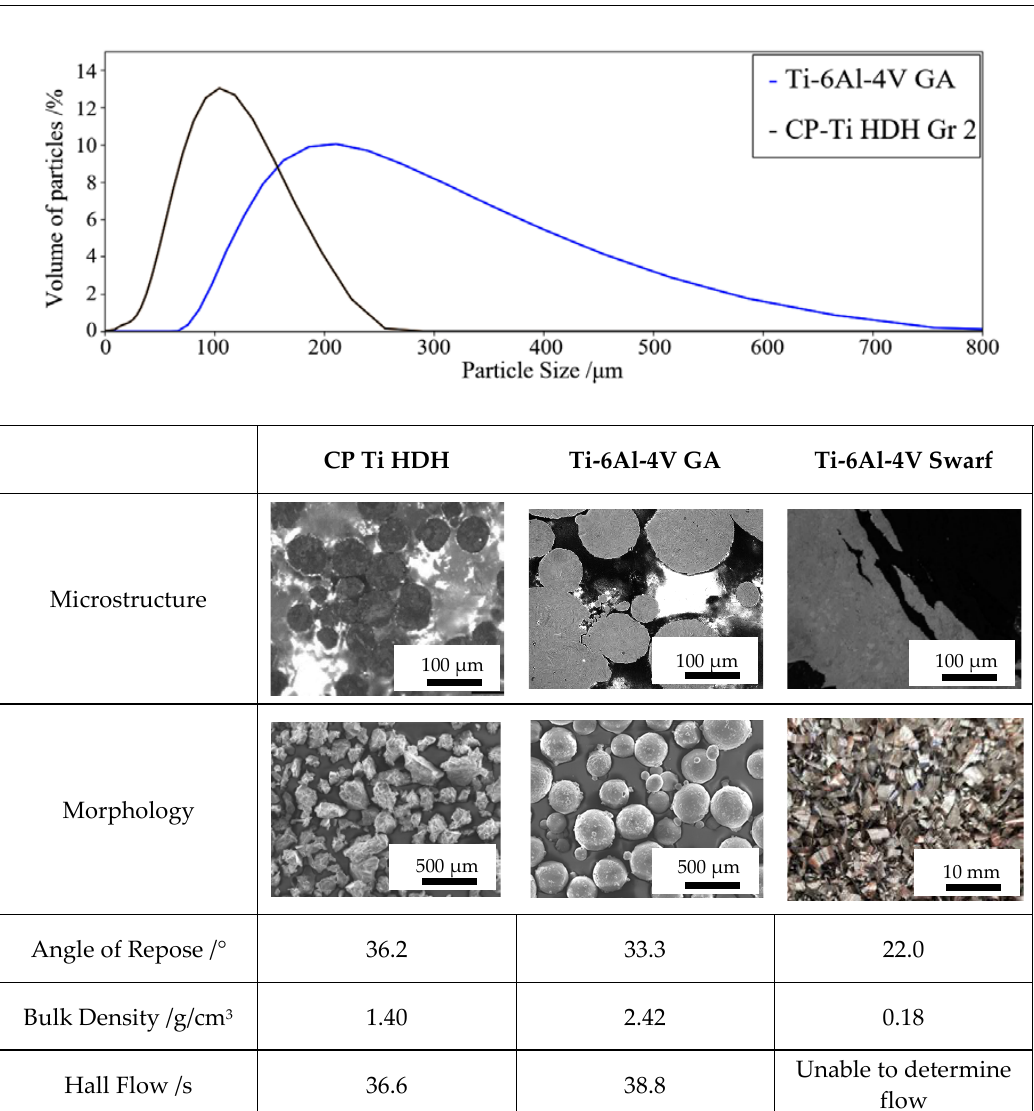
Figure 4. Summary of particle characteristics for titanium alloy feedstocks used in this study. No particle size distribution was recorded for the swarf, owing to a lack of valid techniques for determining this.